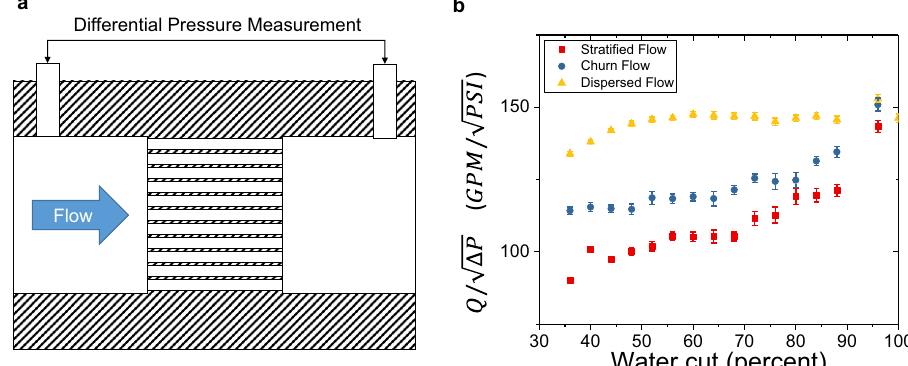
Fig. 5 Pilot-scale experiments for fl ow rate measurements. a A longitudinal cross-section of this our integrated measurement device. The photonic crystal is in the center and the differential pressure gauge access the fl ow through two ports on either side of the photonic crystal. The blue arrow indicates the ffiffiffiffiffiffiffi p 4 P direction of the fl ow. b The rate-to-pressure coef fi cient, A ¼ Q = , determined from the measured fl ow rate and pressure drop as a function of phase fractions (water cut in this case) for the three fl ow regimes tested in the fi eld. Here Q is the volumetric fl ow rate with the unit of gallons per minute (GPM) and Δ P is the pressure drop across the PC structure with the unit of PSI. (Top) Yellow data points correspond to dispersed fl ow, (Middle) blue data points correspond to churn fl ow, and (Bottom) red data points correspond to strati fi ed fl ow. The error bars represent one standard deviation of uncertainty for all data measured at the speci fi c water cut and fl ow